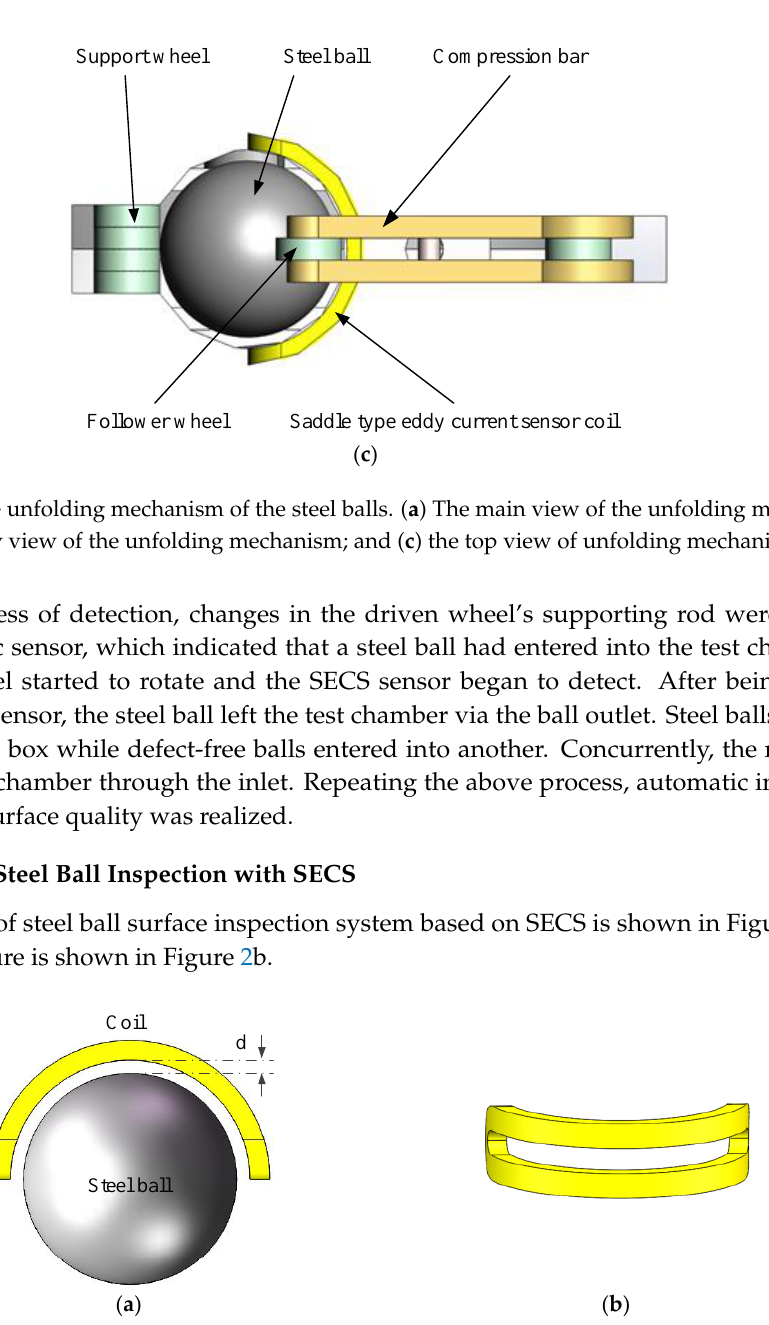
Figure 1. The unfolding mechanism of the steel balls. ( a ) The main view of the unfolding mechanism; ( b ) a cutaway view of the unfolding mechanism; and ( c ) the top view of unfolding mechanism.